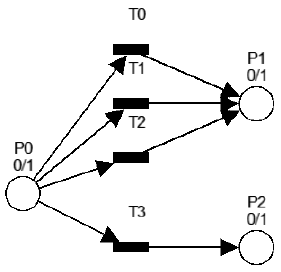
Figure 3. Example of a Petri Net model with random selection.